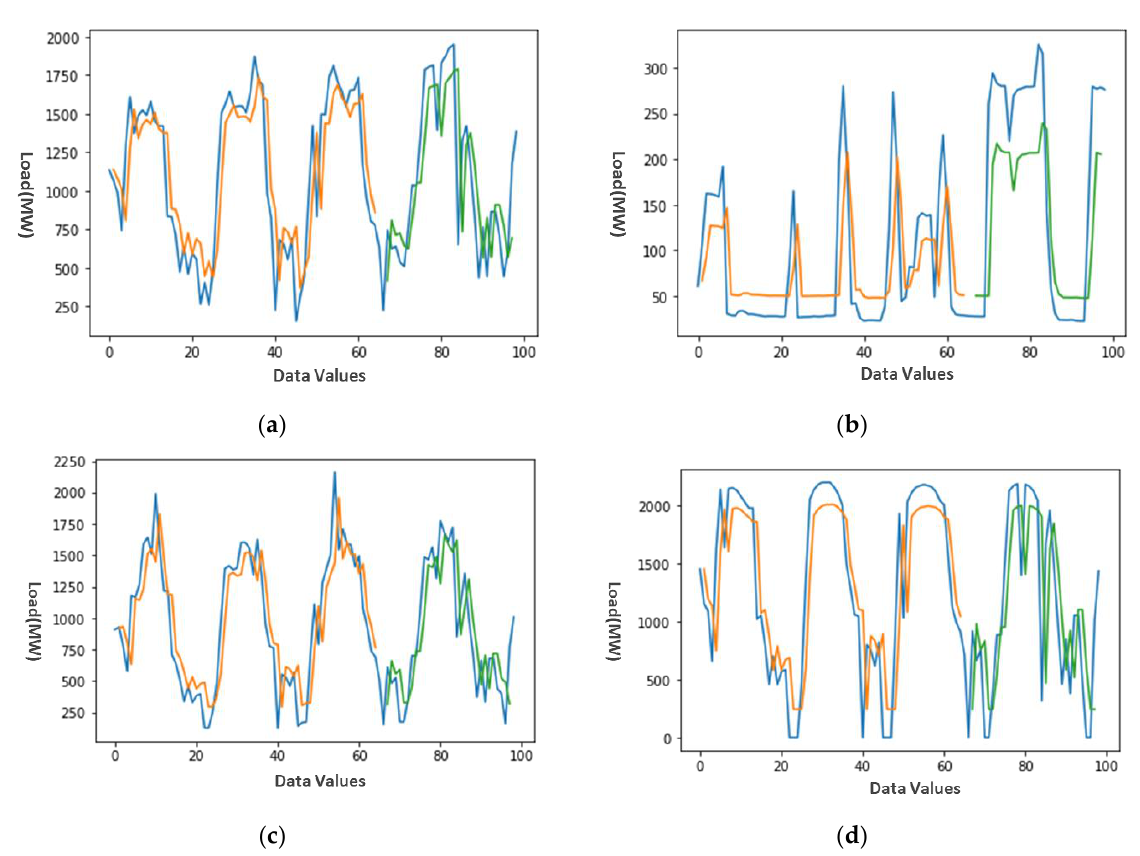
Figure 8. ( a – d ) Load forecasting results of proposed C3-CNN-LSTM model on four different grids. Table 2. Training time, loss, and accuracy of first three epochs of each run.